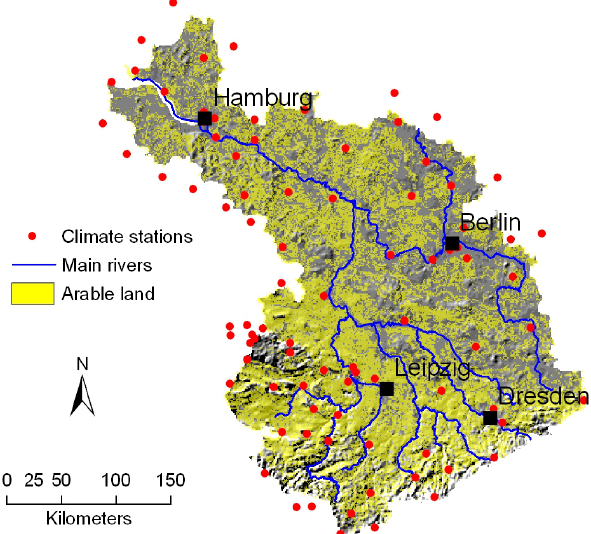
Fig. 3. German part of the Elbe River Basin with climate stations and arable land areas indicated by transparent yellow colour on top of shaded